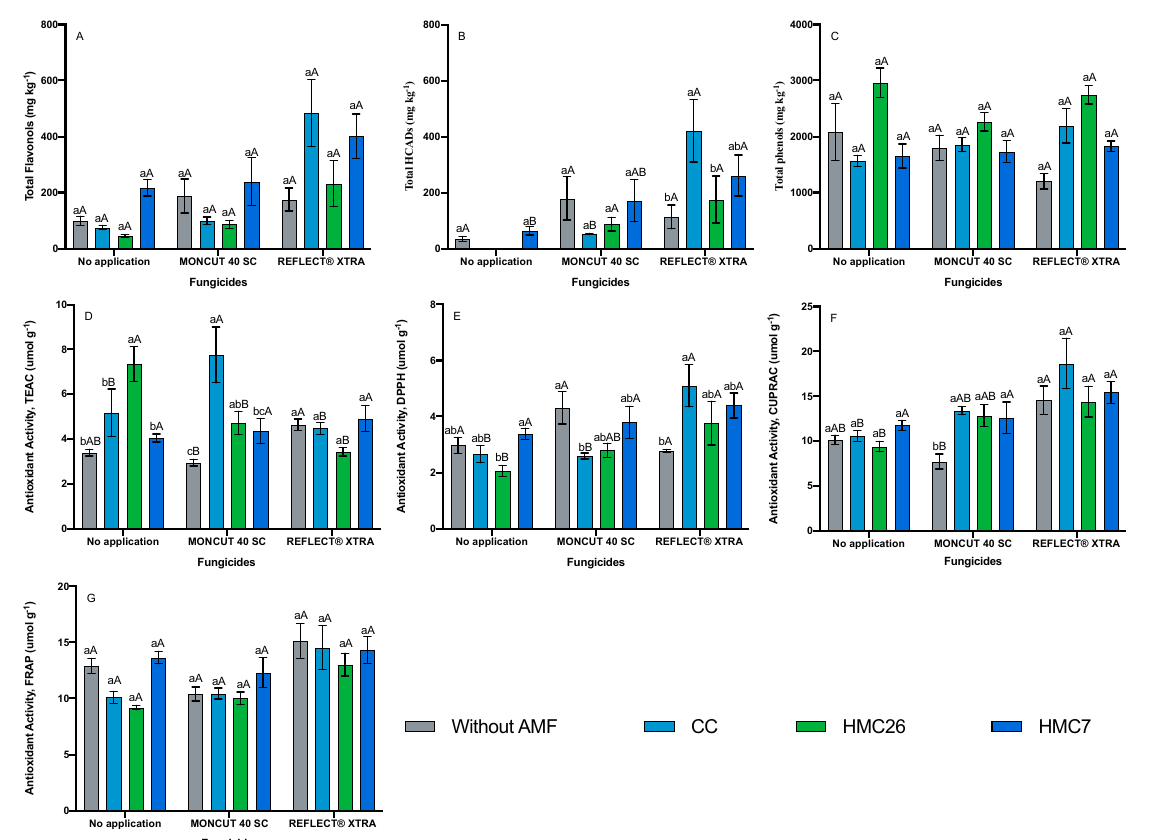
Figure 3. Phenolic compounds and antioxidant activity of Solanum tuberosum leaves, CB2011-509 genotype under inoculation of arbuscular mycorrhizal fungi and fungicide treatments. ( A ) Total flavonols by HPLC-DAD, ( B ) Total hydroxycinnamic acids by HPLC-DAD, ( C ) Total phenols determined by the Folin-Ciocalteu method, ( D ) AA determined by the TEAC (Trolox equivalent antioxidant capacity) method, ( E ) AA determined by the DPPH (2,2-diphenyl-1-picrylhydrazyl) method, ( F ) AA determined by the CUPRAC (copper reducing antioxidant capacity) method and ( G ) AA determined by the FRAP (ferric reducing antioxidant power) assay. Means followed by the same lowercase letter compare inoculation for the same fungicide and uppercase letters compare fungicides within the same inoculation condition (Tukey 5%). Where: without AMF, CC: Claroideoglomus claroideum ; HMC26: Claroideoglomus lamellosum and HMC7 : Funneliformis mosseae . In genotype VR808 (Figure 4A,B), similar concentrations of HCADs and flavonols were observed. The compound with the highest concentration was quercetin-rutinoside, reaching a concentration of 383.58 mg kg − 1 when inoculated with HMC26 and with the use of ReflectXtra (Figure S3). In contrast, no increases were observed with the use of MONCUT compared with levels in the treatment without fungicide.